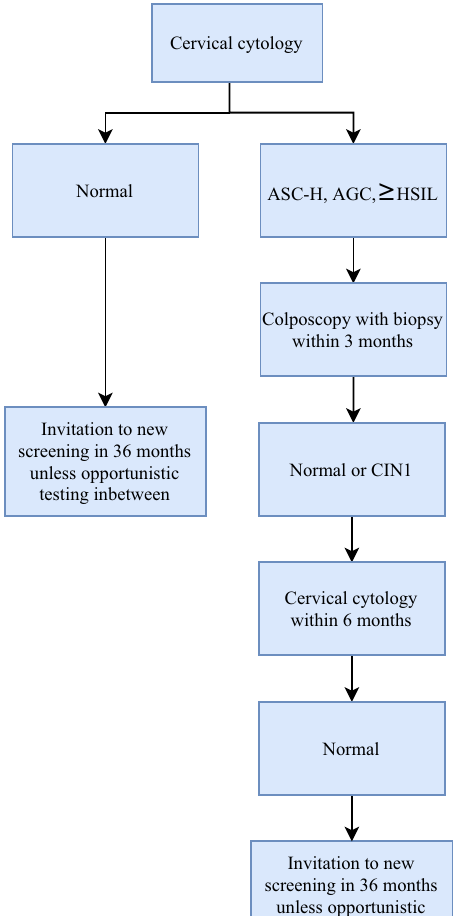
Figure 1. Flowchart of recommendations for the normal and false positive group. ASC-H atypical squamous cells cannot exclude HSIL, AGC atypical glandular cells, HSIL(ASC-H) ≥ HSIL: atypical squamous cells cannot exclude, HSIL high-grade squamousintraepithelial lesion, SCC squamous cell carcinoma, AIS adenocarcinoma in situ, ACC adenocarcinoma, malignant tumor cells CIN1 cervical intraepithelial neoplasi grade